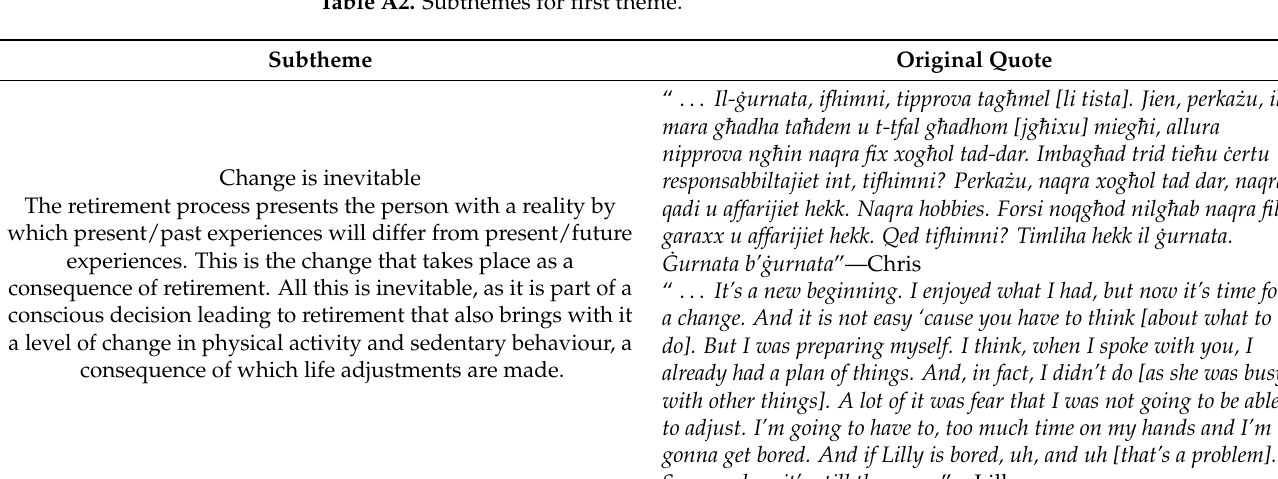
Table A2. Subthemes for first